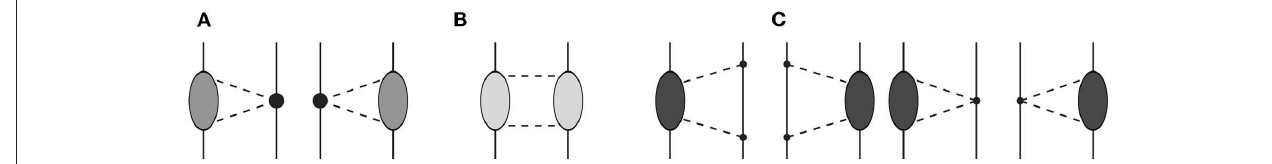
FIGURE 6 | N 5 LO 2 π -exchange contributions to the NN interaction. There are three classes of diagrams. Class (A) is obtained from the subleading one loop π N amplitude folded with the subleading ππ NN vertex proportional to c i . Class (B) is obtained from the leading one-loop π N amplitude folded by itself. Class (C) is obtained from the leading two-loop π N amplitude (represented by a black oval) with the tree-level π N amplitude. Other notation as in Figure 6 . Adapted figure with permission from Entem et al. [48], copyright (2015) by the American Physical Society.